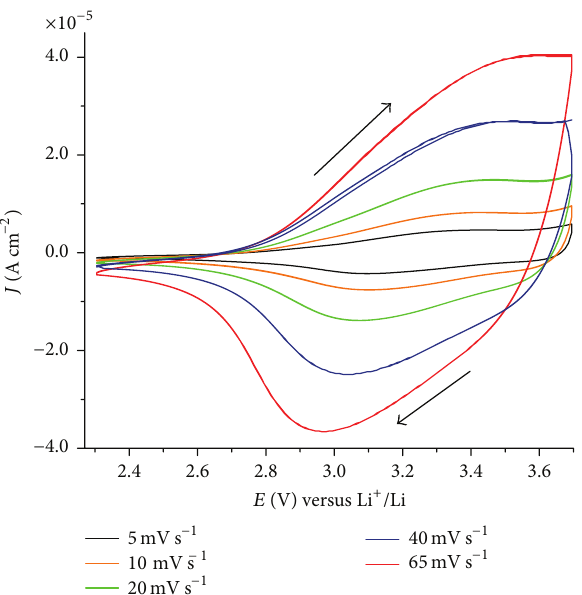
Figure 9: Cyclic voltammograms of CS NiO deposited onto ITO. Voltammograms have been recorded at several scan rates. Counter electrode: Li; reference redox couple: Li + /Li; scan rate: 5 mVs −1 . Electrolyte composition as in Figure 1. Arrows indicate the verse of potential scan.